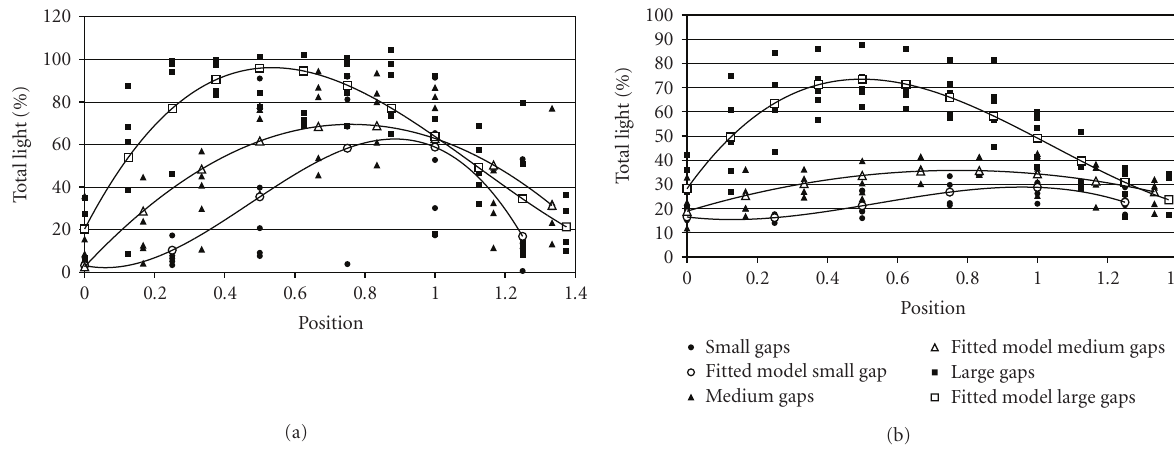
Figure 3: For each method ((a) hemispherical photographs and (b) instantaneous methods) polynomial models as described in Table 2 were fit to the data for percent of total light for each position.